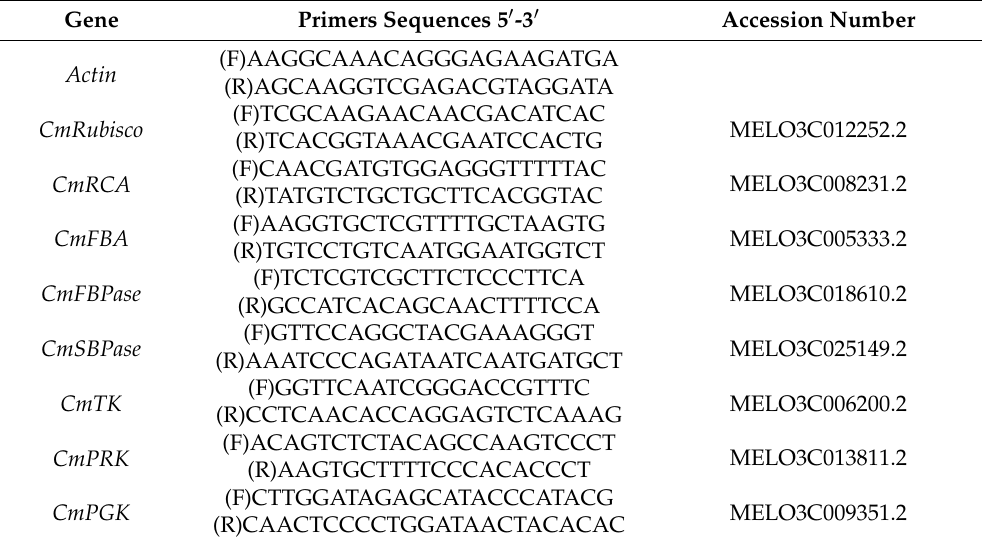
Table 1. Primer list for real-time quantitative PCR.